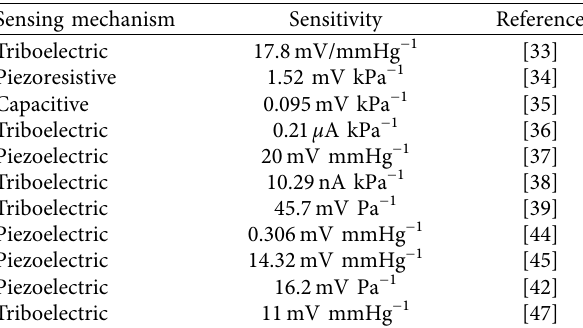
Table 1: Representative sensing system for blood pressure